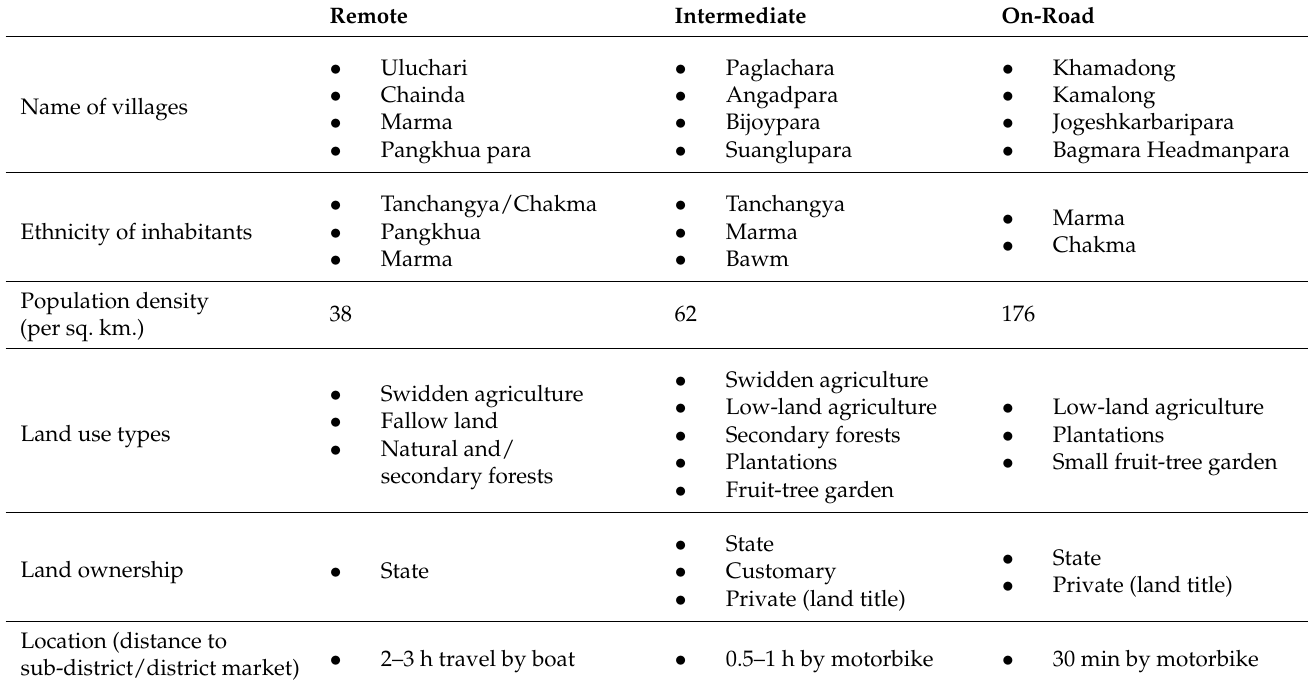
Table 2. Salient features of the villages in three different locations of the CHT region, adapted from [29]. Remote Intermediate